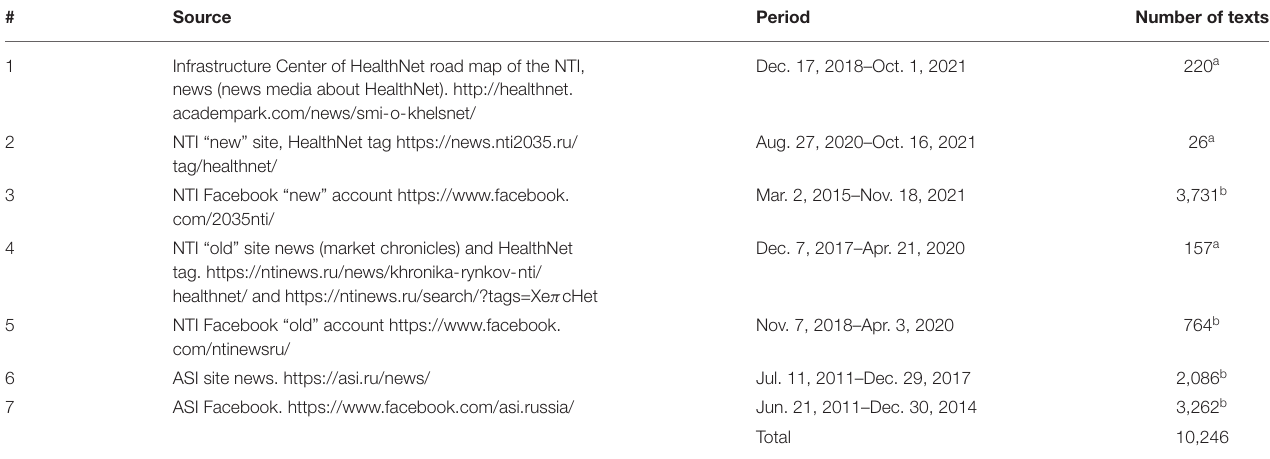
TABLE 2 | Sample sources and period and number of extracted